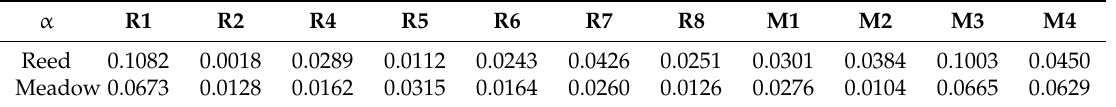
Table 9. The JM-distance values between the individual targets and the mean spectra of the two classes. R1–R2 and R4–R8 represent reed bed targets and M1–M4 represents meadow